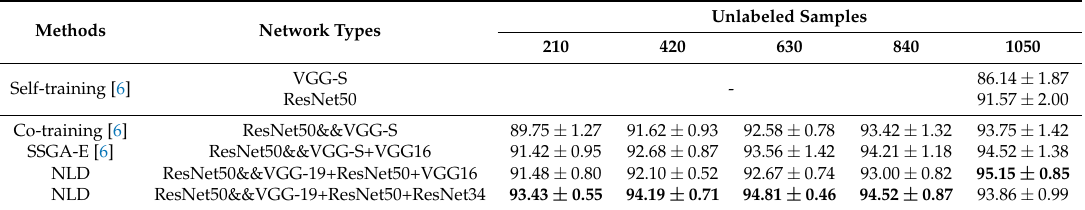
Table 8. The effect of the unlabeled sample ratio on accuracy for the UC Merced Land-use test set reported by Han et al. [6], supplemented with our